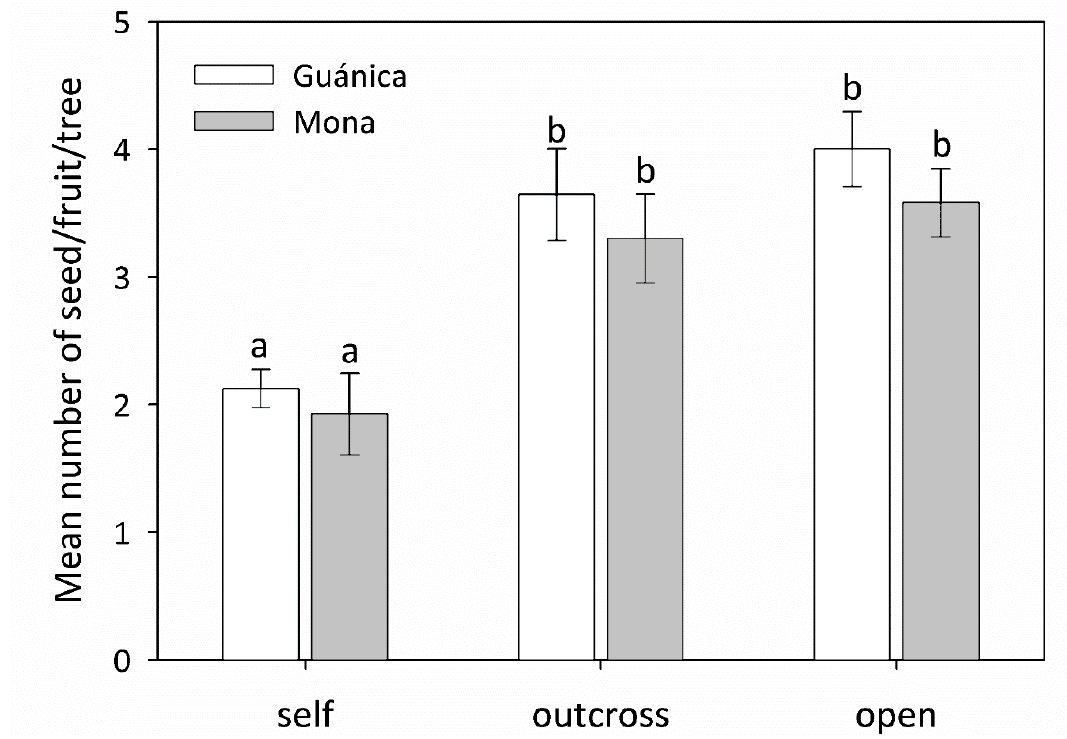
Figure 5. Mean seed-set for different pollination treatments performed in Guánica and Mona Island. Error bars are standard error of the mean. Different letters indicate significant differences (Tukey’s post hoc tests, P < 0.05) among treatments.